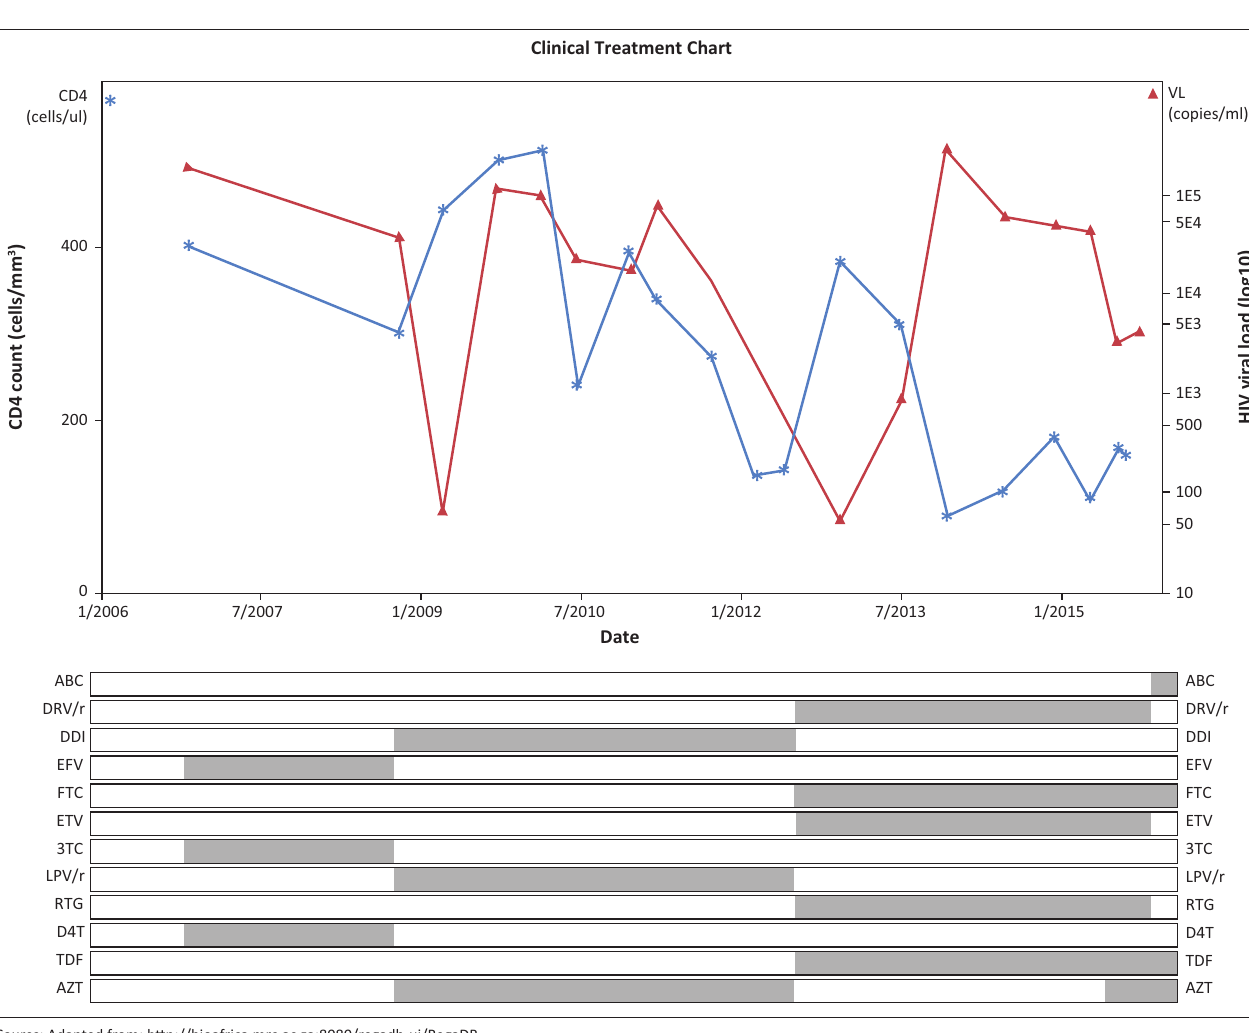
FIGURE 1: Antiretroviral treatment and monitoring data from 2006 to